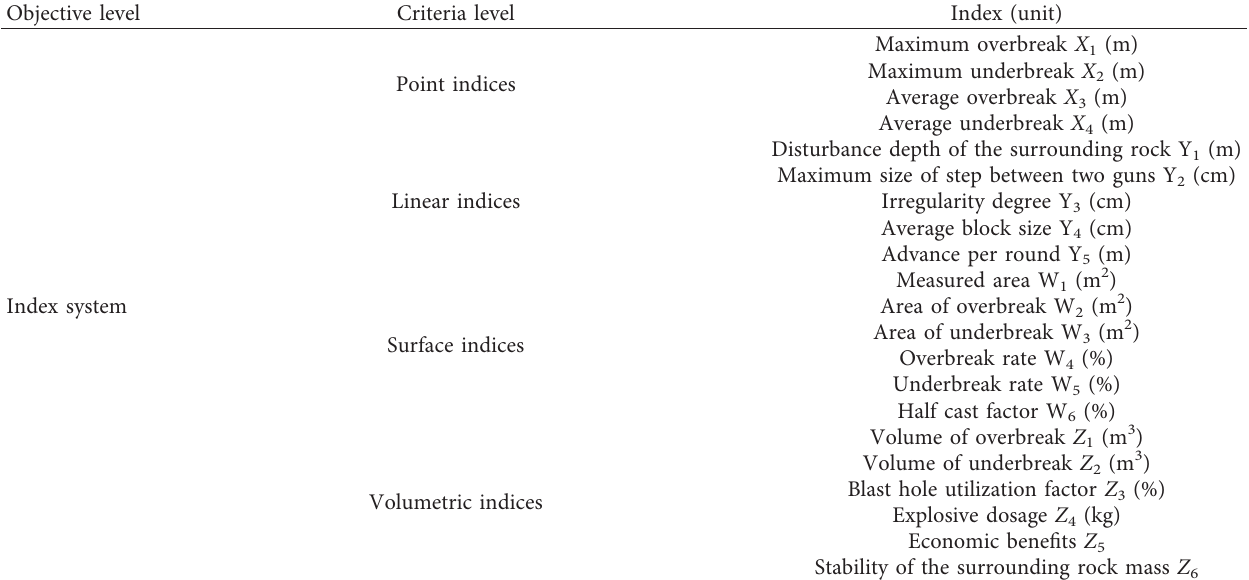
Table 2: Primary determination of the index system in four levels.